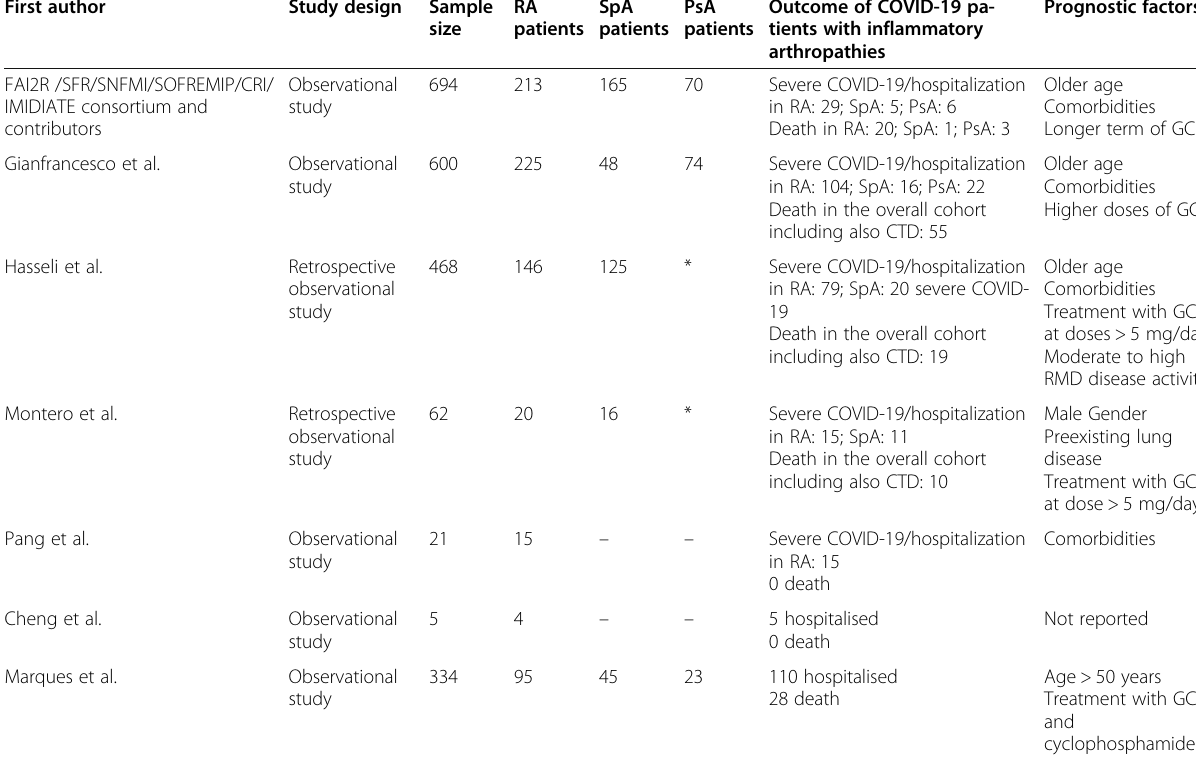
Table 1 Main studies focusing on Incidence, outcomes, and prognostic factors of COVID-19 in rheumatoid arthritis and spondiloarthritis